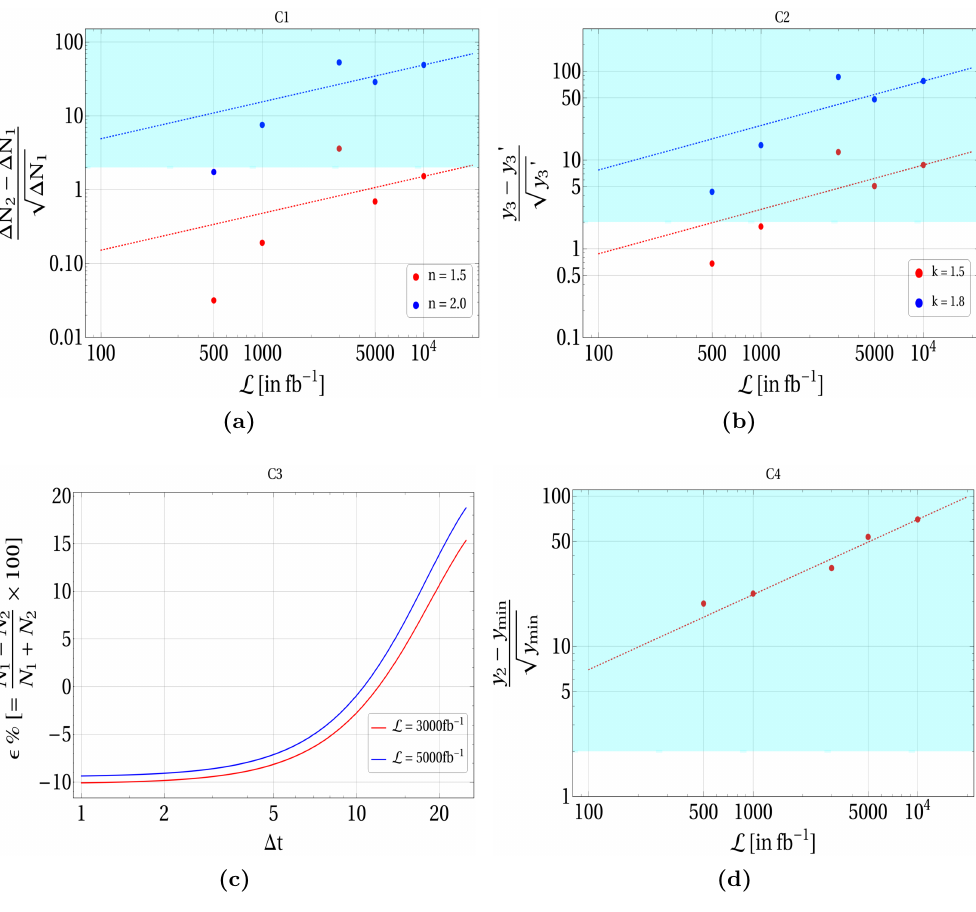
Figure 22. Same as figure 19 but for